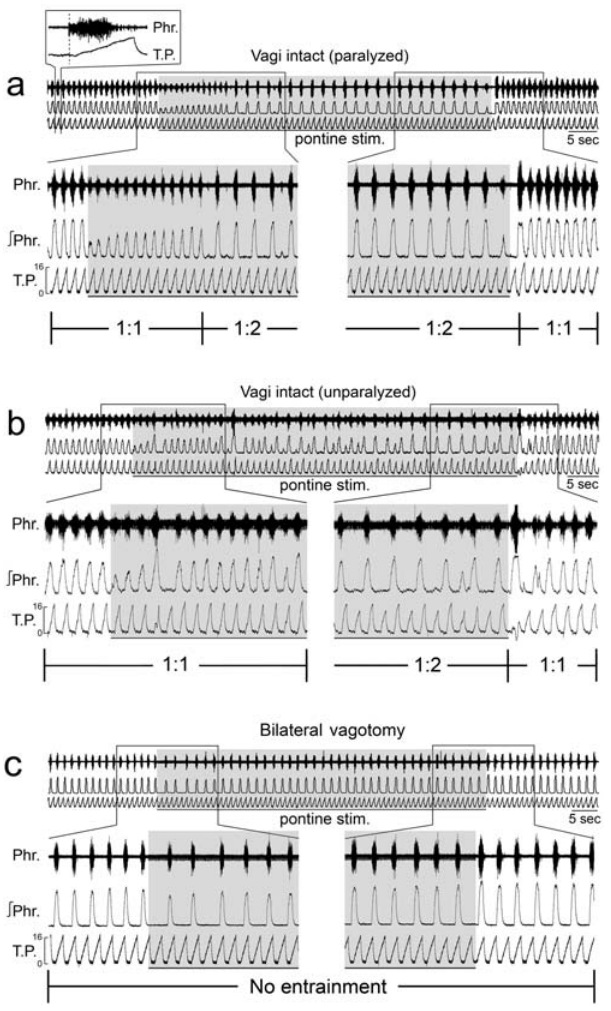
Figure 3. Disruption of respiratory-ventilator entrainment by unilateral stimulation at the dorsolateral pons (pontine stim.) in (a) a paralyzed, and (b) an unparalyzed animal both with intact vagi. Conventions as in Fig. 1. The response in the unparalyzed animal was more variable but the overall effects were similar to those of the paralyzed animal. ( c ) Absence of respiratory-ventilator entrainment before, during or after pontine stimulation in the same animal shown in (a) after